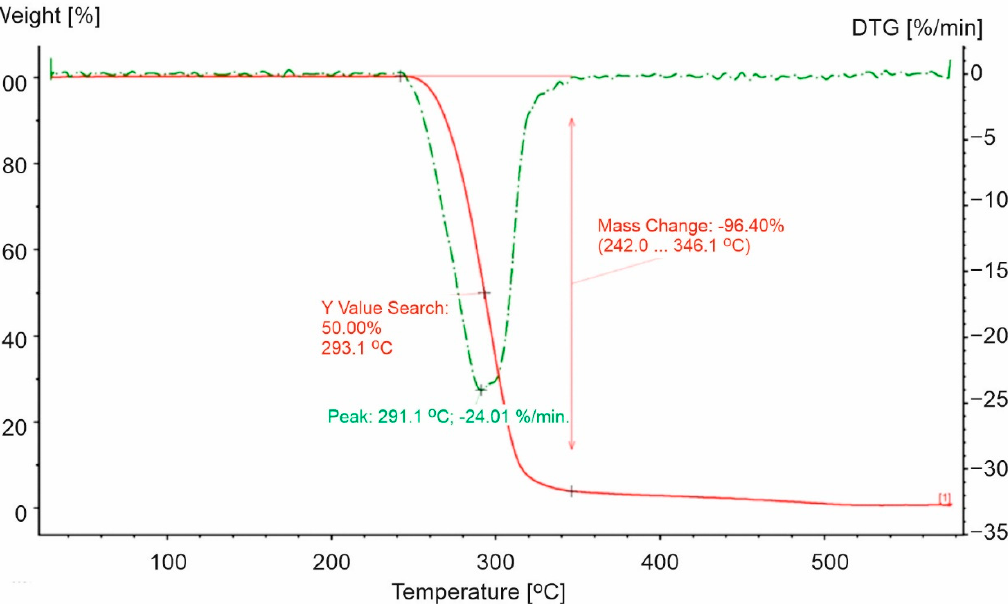
Figure 4. TG and DTG curves for PP-0 in an oxidizing atmosphere (20% O 2 ). The red line presents TG curve, while the green dot line presents DTG